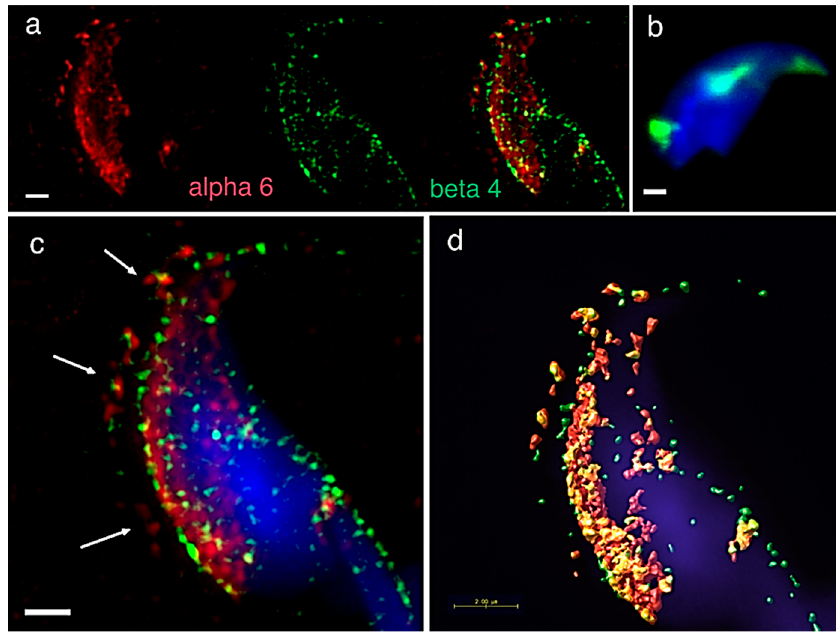
Figure 1. Mutual localization of the α 6 and β 4 integrin subunit and a presence of α 6 β 4 heterodimer revealed by SIM and PLA. ( a ) α 6 (red) and β 4 (green) are localized in the plasma membrane overlying the acrosomal cap (for details see panel c , white arrows), apical hook and equatorial segment in an intact sperm head. ( b ) PLA confirmed the presence of the α 6 β 4 heterodimer in depicted locations ( a ). ( c ) SIM dual-colour imaging showing merged image of α 6 (red) and β 4 (green) localized in the plasma membrane (white arrows). ( d ) Huygens software was used for a better visualization of the colocalization area (yellow). Colocalization maps are based on Pearson’s correlation coefficient. Nucleus is visualized with Dapi (blue). Scale bar represents 1 µm ( a , b , c ) and 2 µm ( d ).